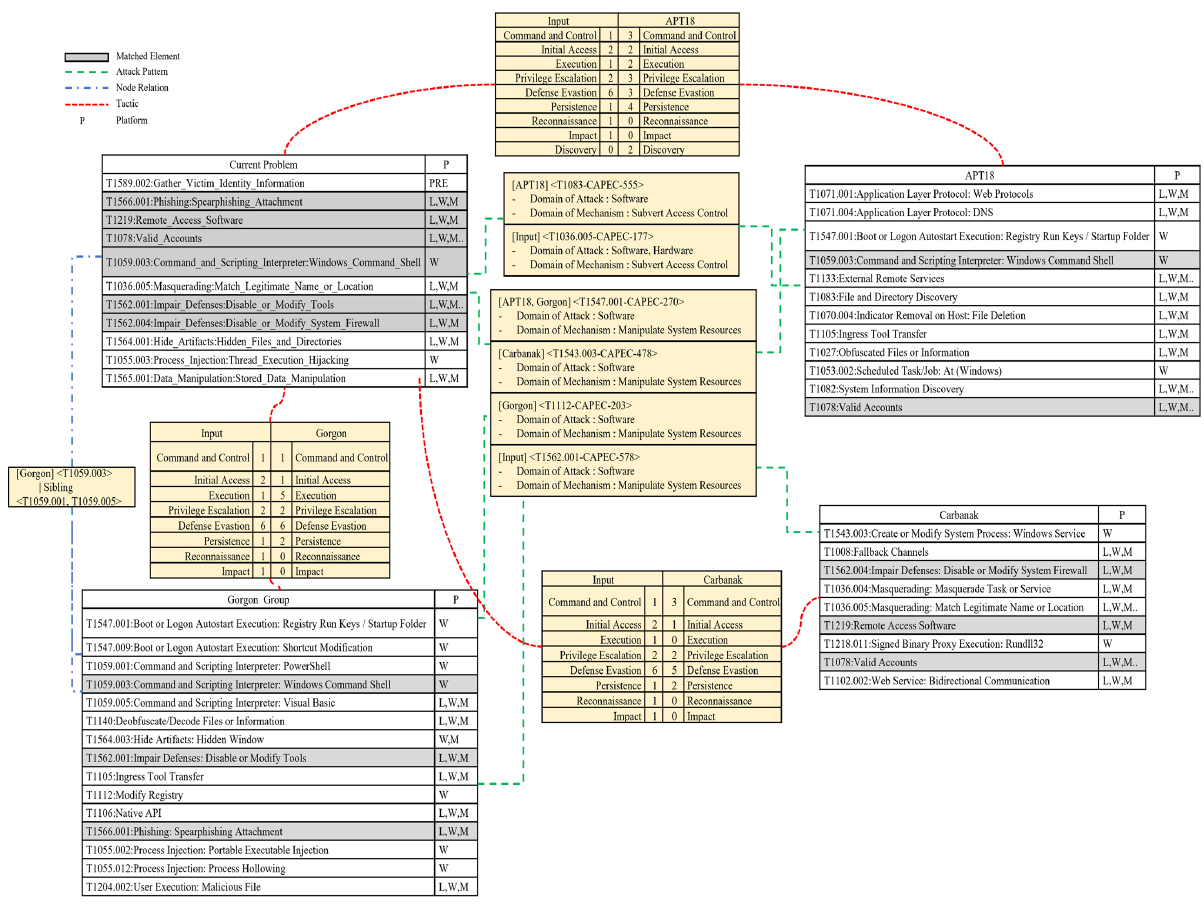
Figure 13. APT feature similarity relationship for the input scenario and each result.